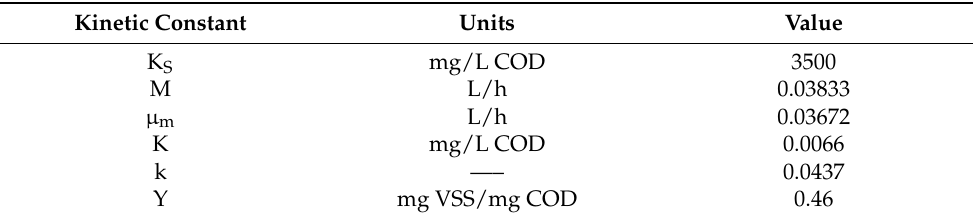
Figure 9. Solid retention time of the process over time.